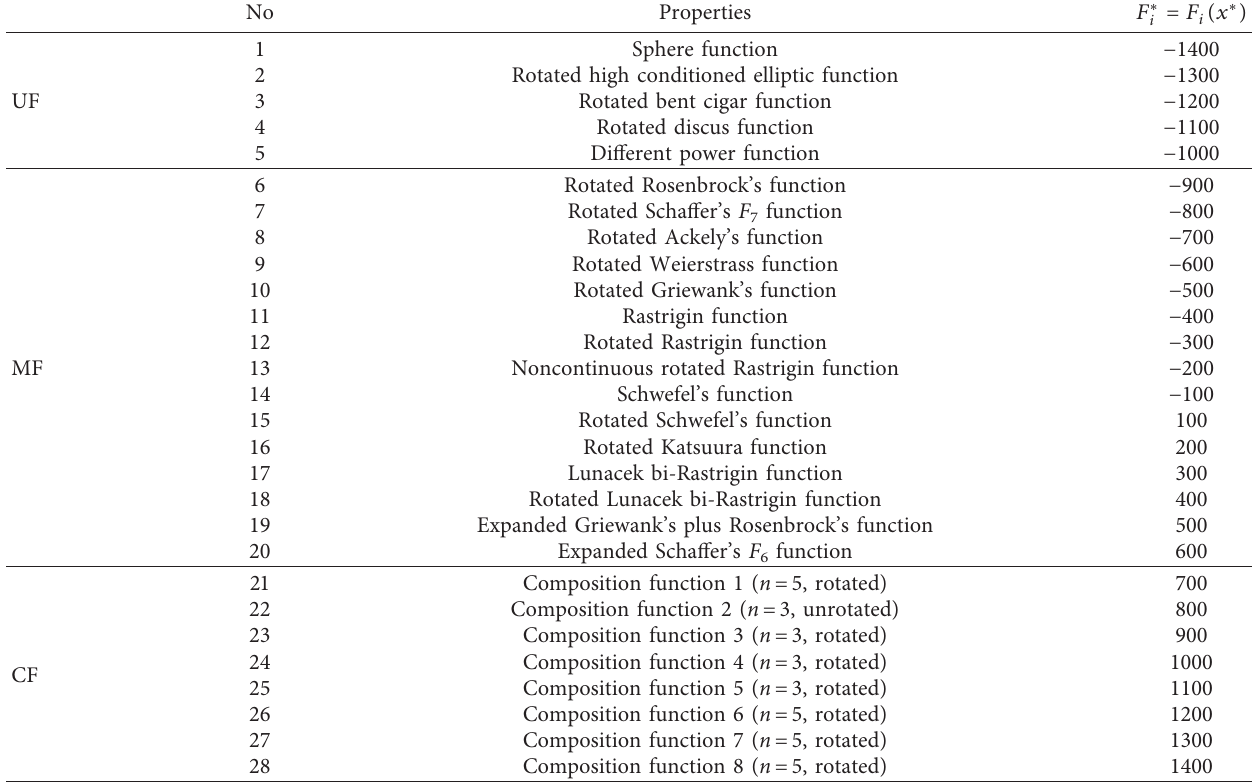
Table 1: The characteristics of the CEC ′ 13 test functions